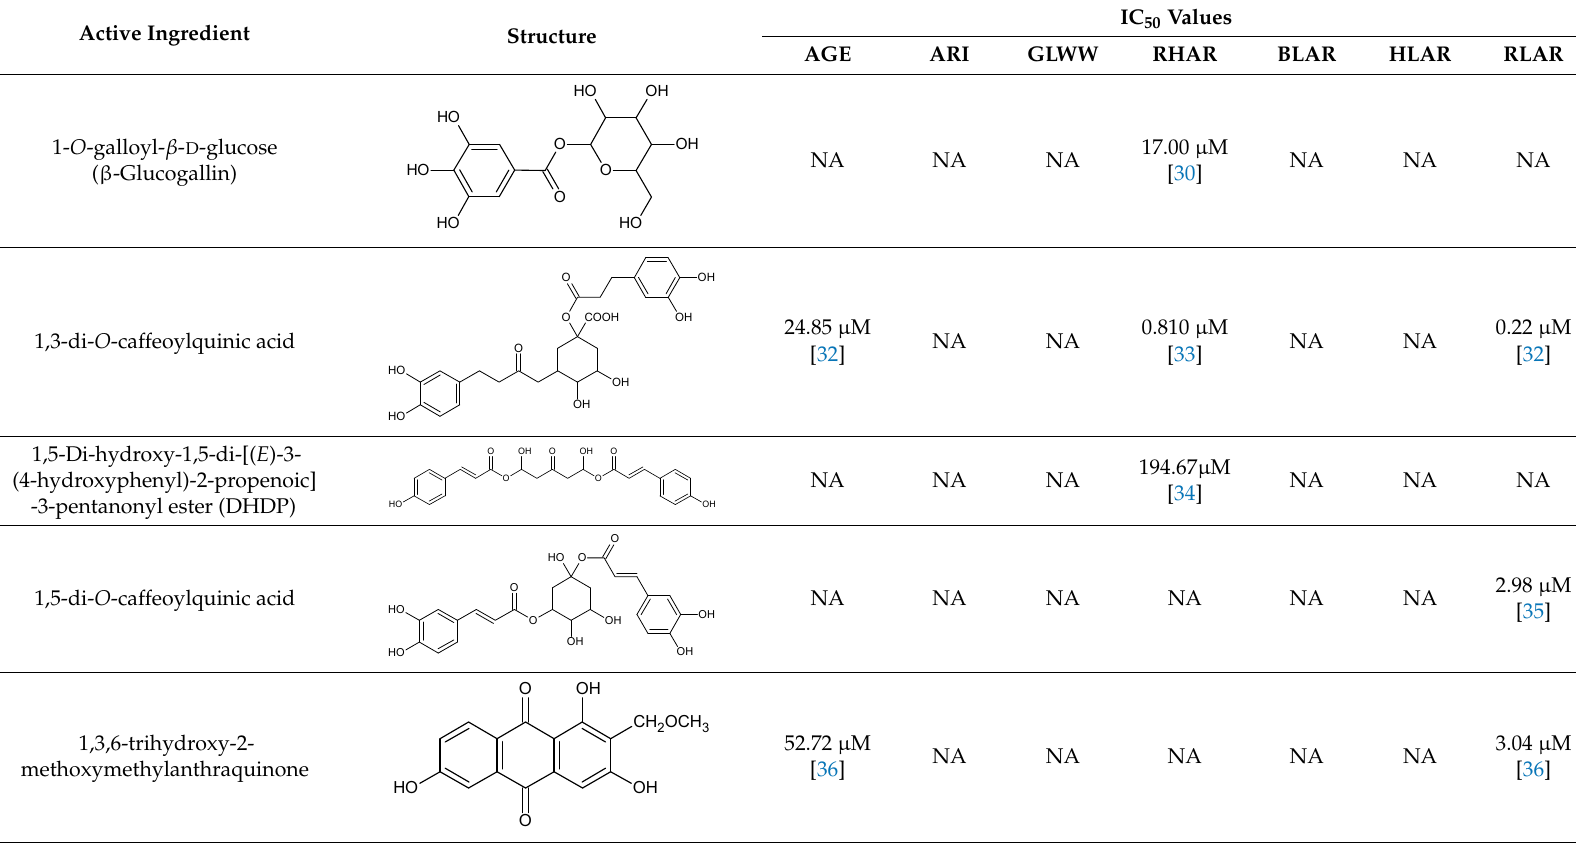
Table 1. Summary of relevant in vitro anti-cataract activities of phytoconstituents.